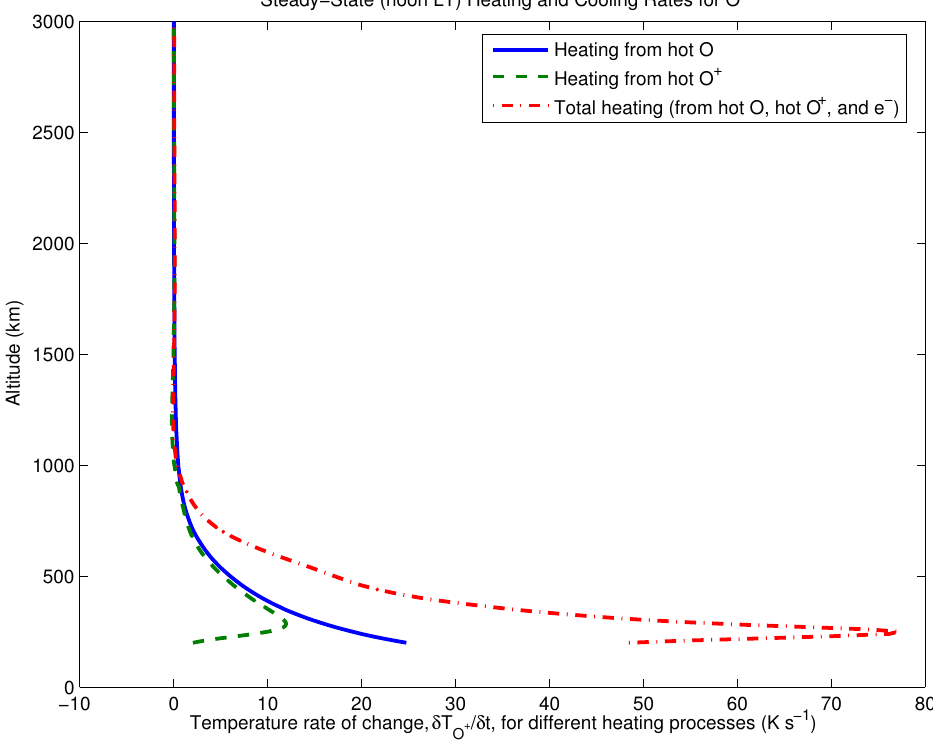
Fig. 6. Loss rate for neutral hot O.